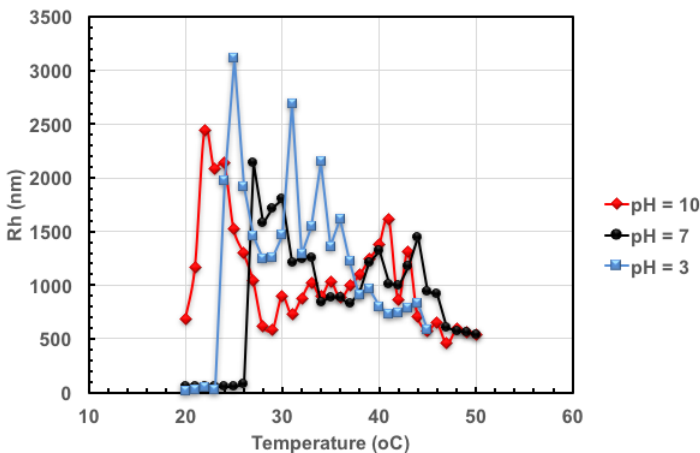
Figure 5. Hydrodynamic radius ( R h ) versus temperature as measured by dynamic light scattering (DLS) for the various 1 wt% aqueous solutions of the poly(MAA- stat -2VP)- b -poly(4AM- stat -4AP) block copolymer in different buffers.